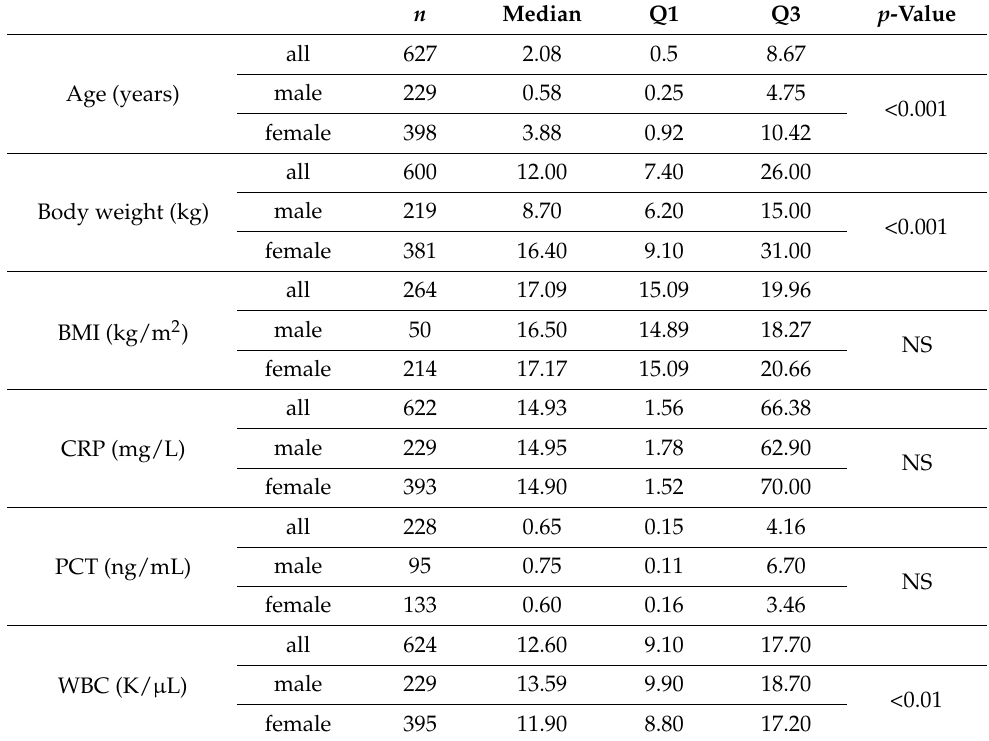
Table 1. Demographic, anthropometric and biochemical parameters in patients; comparisons between males and females.